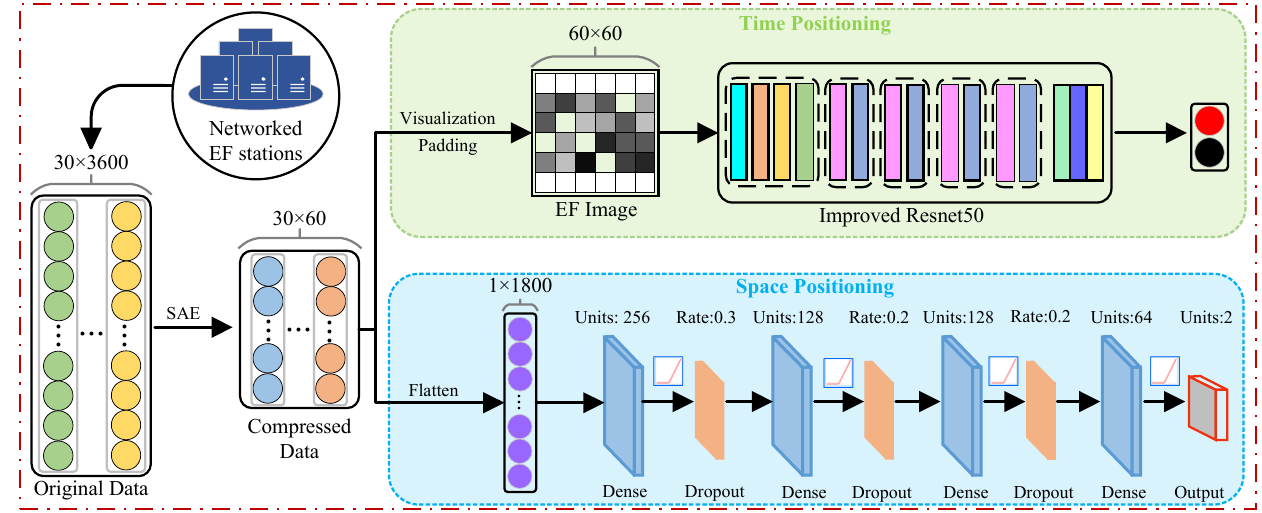
Figure 13. Architecture of the lightning warning algorithm (the blue rounded rectangle is the time positioning module and the blue rounded rectangle is the space positioning